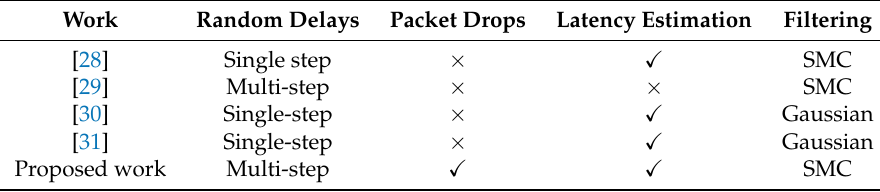
Table 1. Features comparison for proposed work and previous